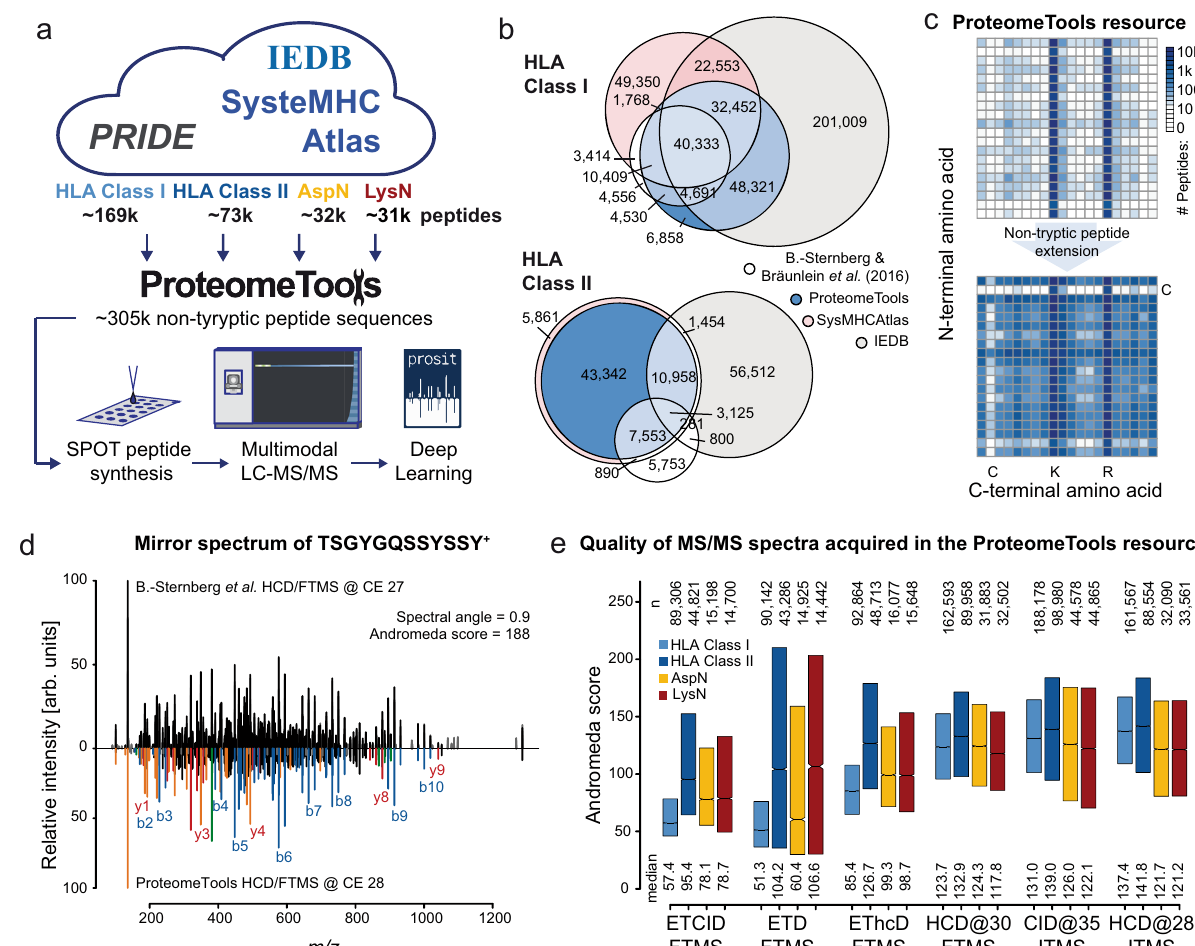
Fig. 1 ProteomeTools ’ non-tryptic peptide extension. a The ProteomeTools resource was extended in this study by ~305 k non-tryptic synthetic peptides consisting of ~169 k HLA class I, ~73 k HLA class II, ~32 k AspN and 31 k LysN peptides. All peptides were systematically characterized by multimodal LC- MS/MS. All data were subsequently used for training the 2020 Prosit fragment intensity prediction model. b Proportional Venn diagrams of HLA class I (top) and HLA class II (bottom) peptides in ProteomeTools (blue), SysteMHC Atlas (light red), IEDB (gray), and B.-Sternberg et al. 11 . (white). c Number of peptides (log10 color scale, white to dark blue) synthesized for the ProteomeTools resource sorted by N- ( y -axis) and C-terminal ( x -axis) amino acid without (top) and with (bottom) the extension of non-tryptic peptides from this study. d Mirror spectrum of the singly charged non-tryptic peptide TSGYGQSSYSSY acquired by B.-Sternberg and Bräunlein et al. 11 (endogenous peptide, top) and ProteomeTools (synthetic peptide, bottom). Fragment ion peaks with and without neutral losses are annotated in blue, red, green, and orange for b-, y-, a- and internal fragment ions, respectively. The spectral similarity measured by the normalized spectral contrast angle between the two spectra and the Andromeda matching score of the top spectrum are shown in the top. e Boxplots of Andromeda scores for the best MS/MS identi fi cation per precursor for HLA class I (dark blue), HLA class II (light blue), AspN (yellow), and LysN (red) peptides for different fragmentation settings (HCD, CID, ETD, EThcD, ETciD) and mass analyzers (FTMS: Orbitrap mass analyzer, ITMS: ion trap mass analyzer). The number of spectra (n) and median Andromeda score (median) are depicted at the top and bottom of the boxplot. The box indicates the interquartile range (IQR). The black line marks the median, notches extend to 1.58 * IQR/sqrt(n), no whiskers or outliers outside IQR shown. Raw and analysis data are available from the PRIDE repository with identi fi er PXD021013. slight improvement for tryptic peptides (SA > = 0.9 for 46% vs analysis of both tryptic and non-tryptic peptides. A representative 50%; Fig. 2b). The 2020 model performed drastically better for example is shown in Fig. 2d (YPYPVSNSV; [M + H] + ; gene ATXN2L ). It is apparent that the experimental and predicted singly charged peptides (median SA of 0.89 vs 0.56; Fig. 2c) and fragment ion intensities of the annotated b- and y-ions are in very also improved prediction accuracy for higher charged peptides good agreement (SA = 0.88). Perhaps surprisingly, no major bia- (Supplementary Fig. S7a), across different C-terminal amino acids ses were observed when comparing measured and predicted b- (Supplementary Fig. S7b, c) as well as peptides with internal or N- and y- fragment ion intensities even for peptides that show terminal basic residues (Supplementary Fig. S7d, e). The 2020 dominant internal or neutral loss ion series (Fig. 1d; Supple- model also performed well across the different peptide sets, pre- cursor charges, and the wide range of collision energies used for training (Supplementary Fig. S8a – c) and showed little bias for C- terminal amino acids (Supplementary Fig. S8d) and combinations of peptide N- and C-termini (Supplementary Fig. S9). This demonstrates that the 2020 Prosit model is well suited for the NATURE COMMUNICATIONS|